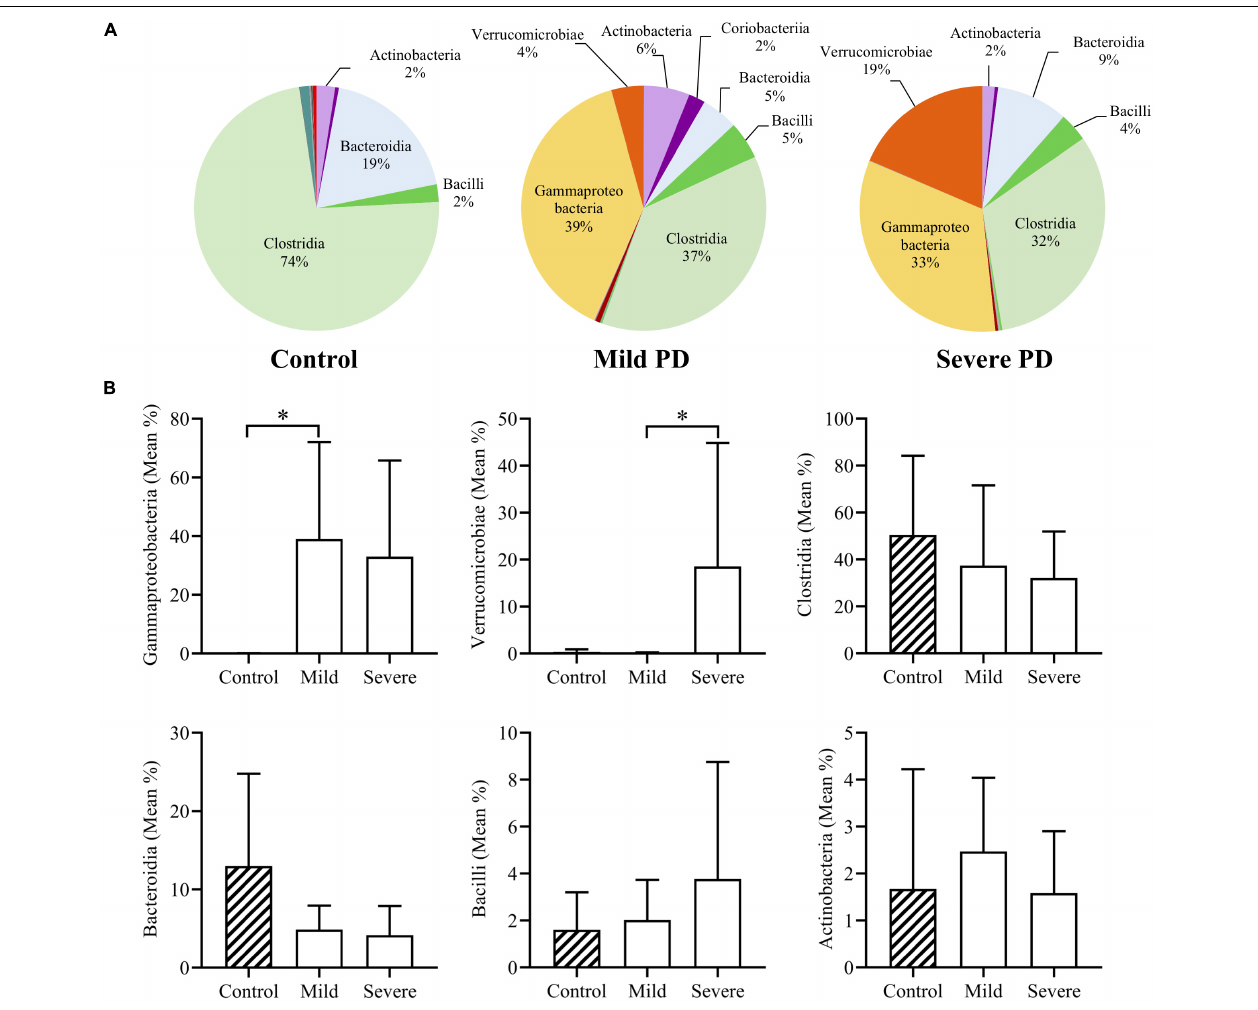
FIGURE 1 | Mean class abundance in people with Parkinson’s disease and healthy controls. Individuals with Parkinson’s disease (PD) were grouped by a clinician. Pie charts illustrate the mean relative abundance of bacterial classes in healthy controls and individuals with mild or severe PD (A) . Comparison of the six most abundant classes demonstrates a significant increase in Gammaproteobacteria in mild PD compared to controls (621.22 × fold, p < 0.05), and significantly elevated levels of Verrucomicrobiae in severe PD patients, when compared to mild PD patients (4.35 × fold, p < 0.05) (B) .